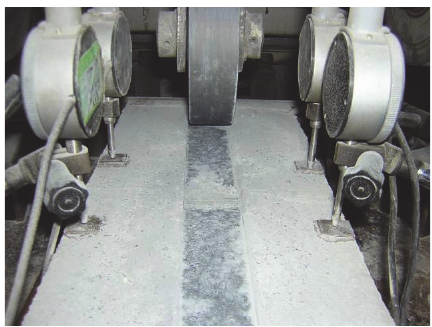
Figure 7: Similarity model test.